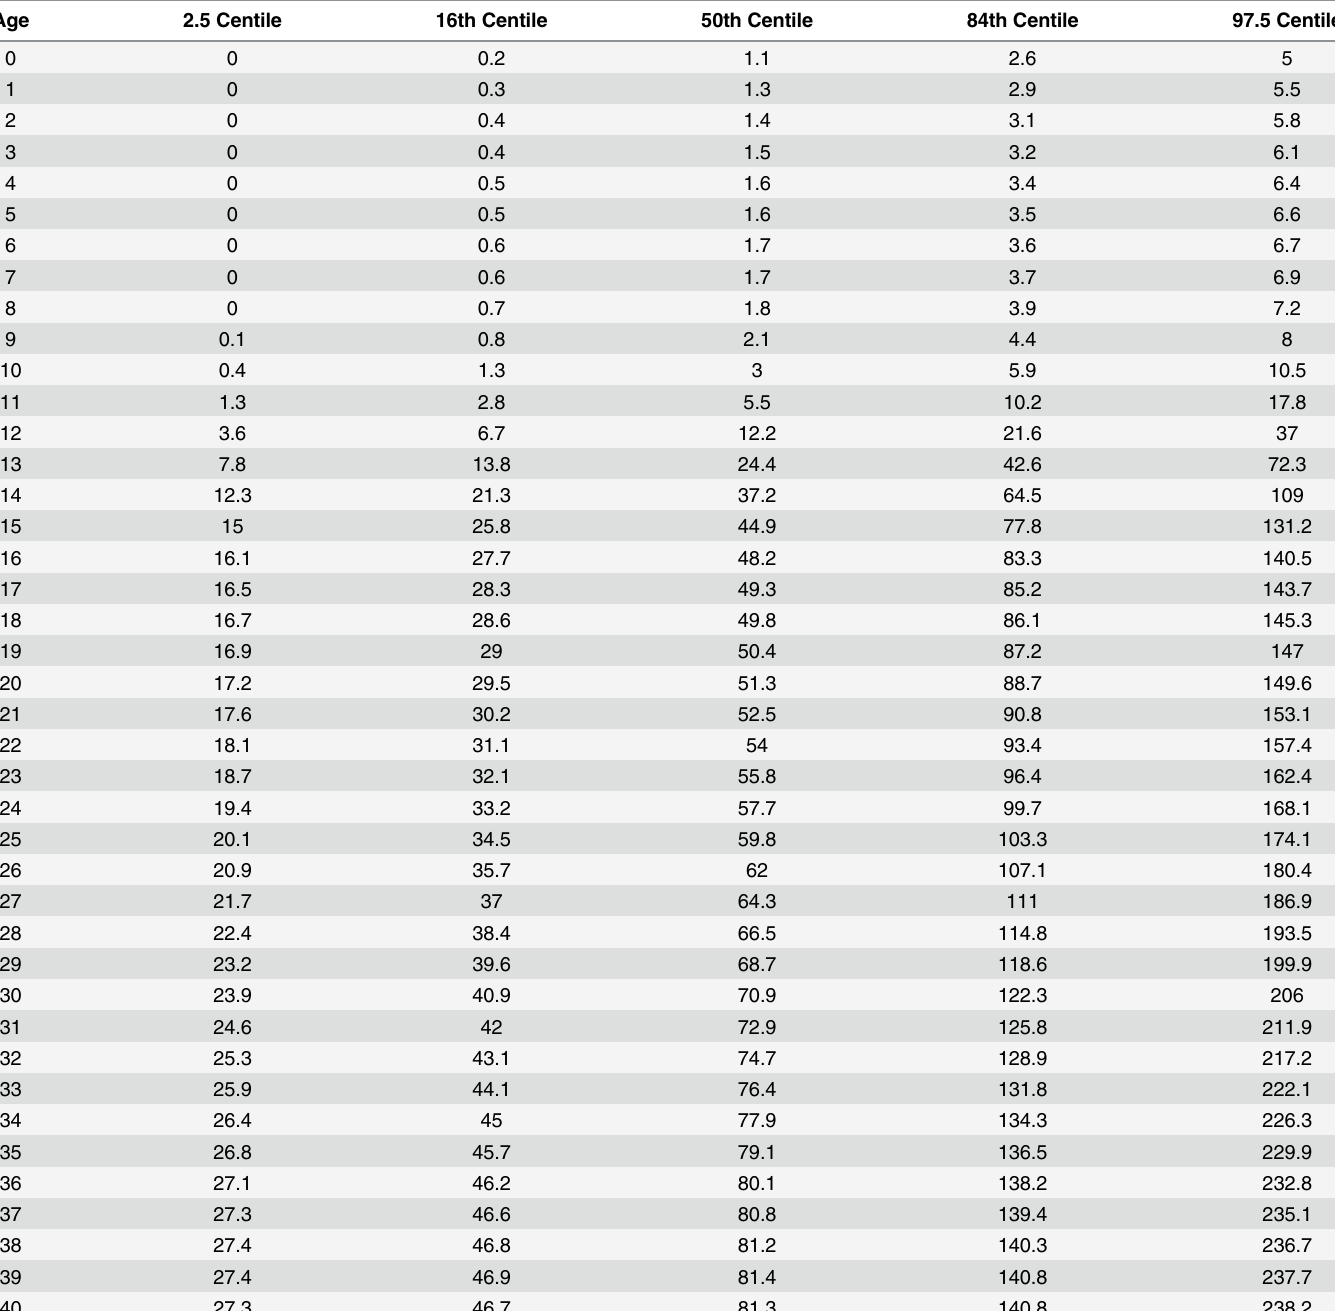
Table 5. Normative Uterine Volumes. Mean volumes (50th centile) in cm 3 are given for ages 0 to 40. Also given are volumes at one standard deviation from the mean (16th and 84th centiles) and at two standard deviations from the mean (2.5 and 97.5